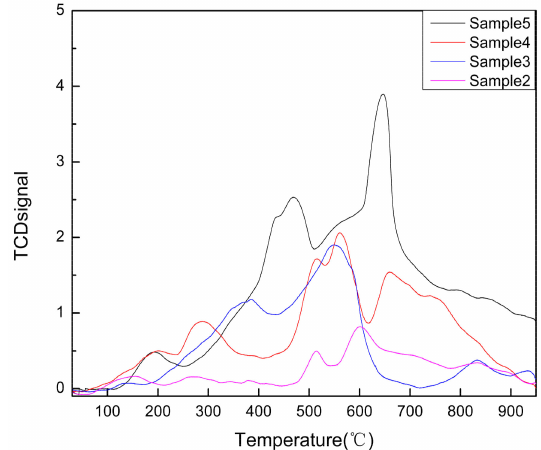
Figure 10. NO-TPD curve of modified rare earth